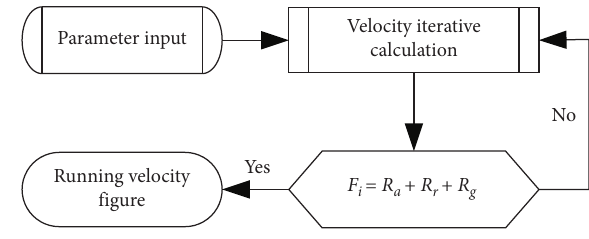
Figure 3: The framework of the simulation